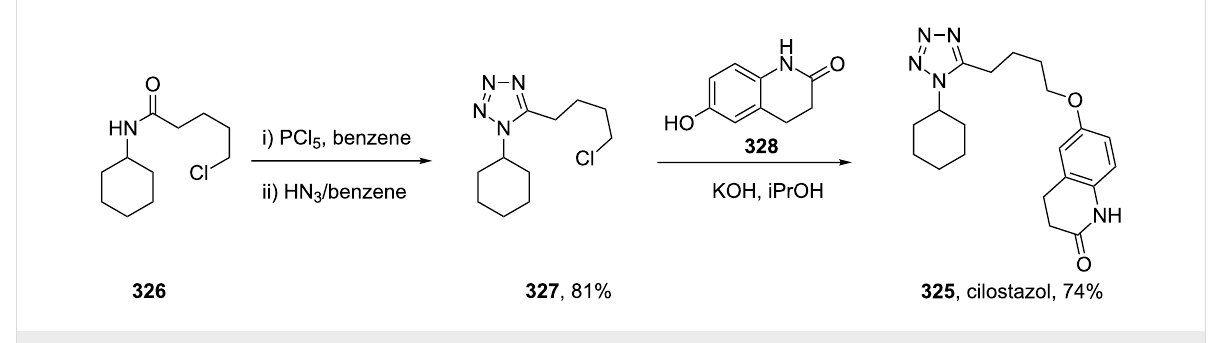
Scheme 64: Synthesis of cilostazol.